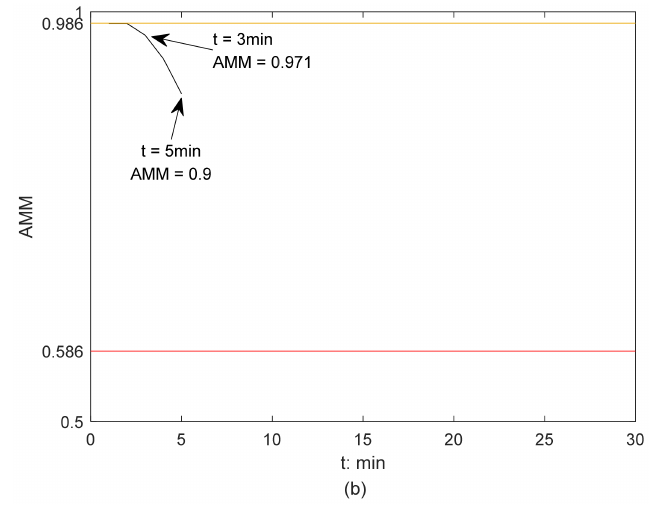
Figure 7. Illustration of the activation of AMM-based CAS from GW perspective in Scenario 2, without ship stability considered: ( a ) collision alert level determination; ( b ) the change of AMM of a GW.